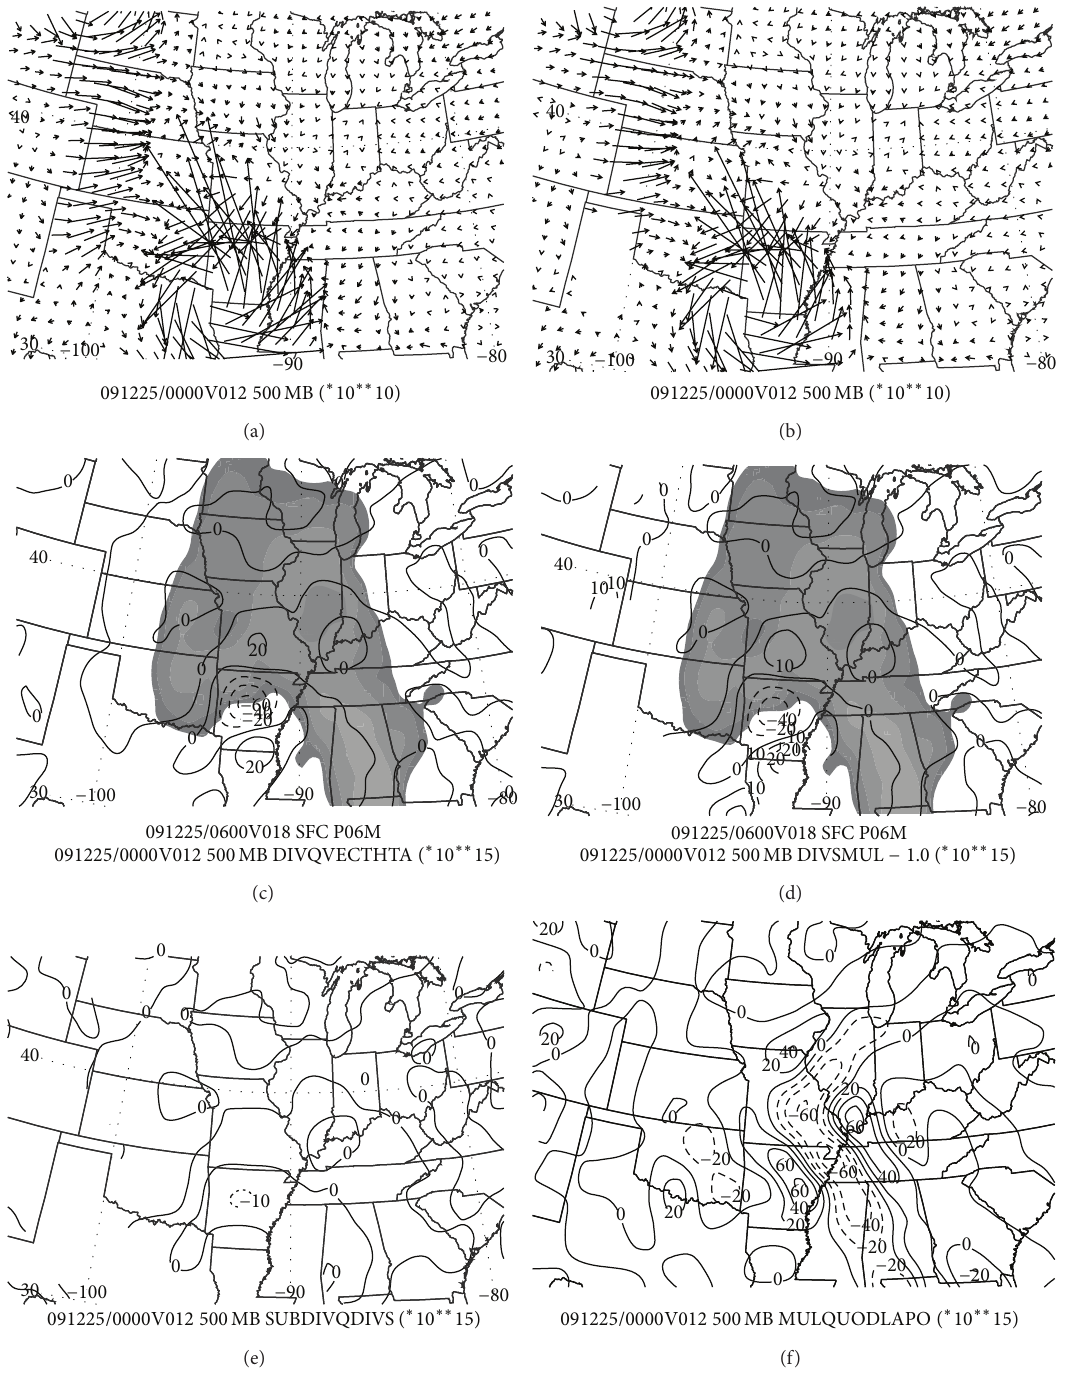
Figure5: 𝑄 -vectordiagnosticsfromtheNAMmodelruninitializedat1200UTC24December2009andvalidat0000UTC25December2009 (12-hour solutions), including (a) standard 500-hPa 𝑄 (hPam −1 s −1 ), (b) the diabatic form of the 500-hPa 𝑄 (hPam −1 s −1 ), (c) the divergence ⃗𝑄 of the standard 500-hPa, ∇ ⋅ (every 20 × 10 −15 hPa m −2 s −1 ; values < 0 are dashed; values of 0 or greater are solid), (d) the divergence of the ⃗𝑄 diabatic form of the 500-hPa, ∇ ⋅ (every 20 × 10 −15 hPa m −1 s −1 ; values < 0 are dashed; values of 0 or greater are solid), (e) the difference in divergence between the standard and diabatic forms of the 500-hPa 𝑄 (every 10 × 10 −15 hPa m −1 s −1 ; values < 0 are dashed; values of 0 or greater are solid), and (f) the Laplacian of pressure vertical motion, −( 1 / 2 )∇ 2 𝜔 (every 20 × 10 −15 hPa m −1 s −1 ; values < 0 are dashed; values of 0 or greater are solid). Frames (c) and (d) also feature the 6-hour precipitation (shaded at 2, 4, 10, and 20 mm), accumulated in the model in the ensuing 6-hour period, ending at 0600 UTC 25 December